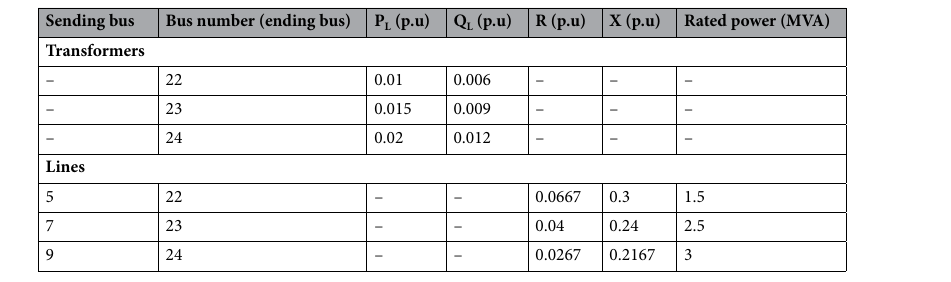
Table 3. Transformers and load information 20